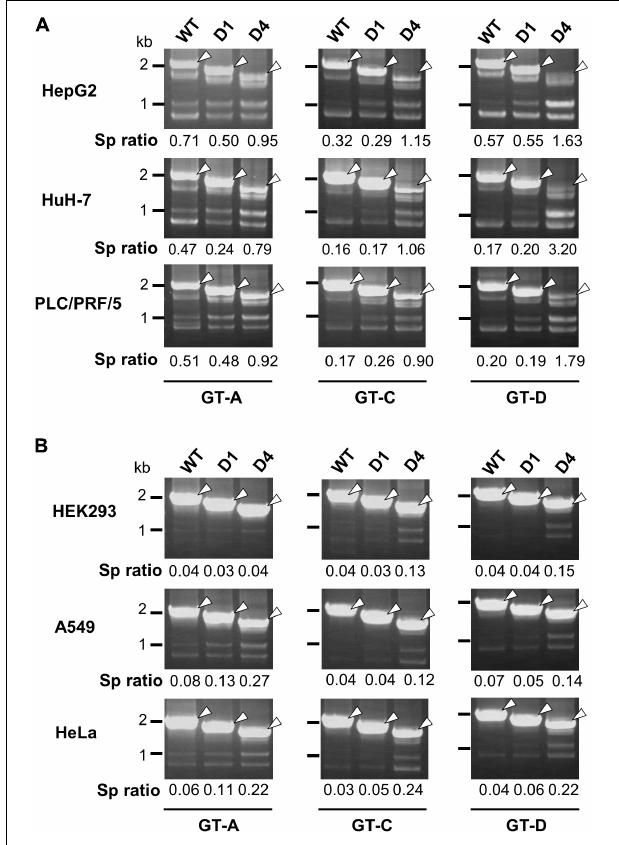
FIGURE 4 | Effect of deletions in intron region of the HBV genome on the splicing efficiency in human HCC and non-hepatic cells. RT-PCR analyses of HBV RNAs expressed from WT and deletion-mutants corresponding to D1 and D4 derived from GT-A (deleted regions; nt 2990–3202 in D1, nt 2864-48 in D4), -C (nt 2984–3196 in D1, nt 2858-48 in D4) and -D (nt 2951–3163 in D1, nt 2858-48 in D4) in human HCC (HepG2, HuH-7 and PLC/PRF/5) cells (A) and in non-hepatic (HEK293, A549, and HeLa) cells (B) . Sp ratio; the quantity ratio of the spliced RNAs to the unspliced RNA. Open arrows, unspliced